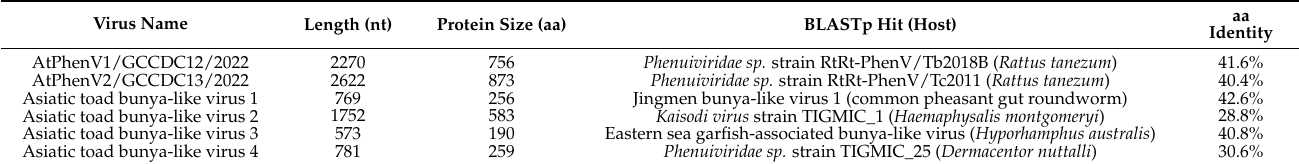
Table 3. Genomic characterization of bunyaviruses identified in the Asiatic toad and BLASTp hits on known